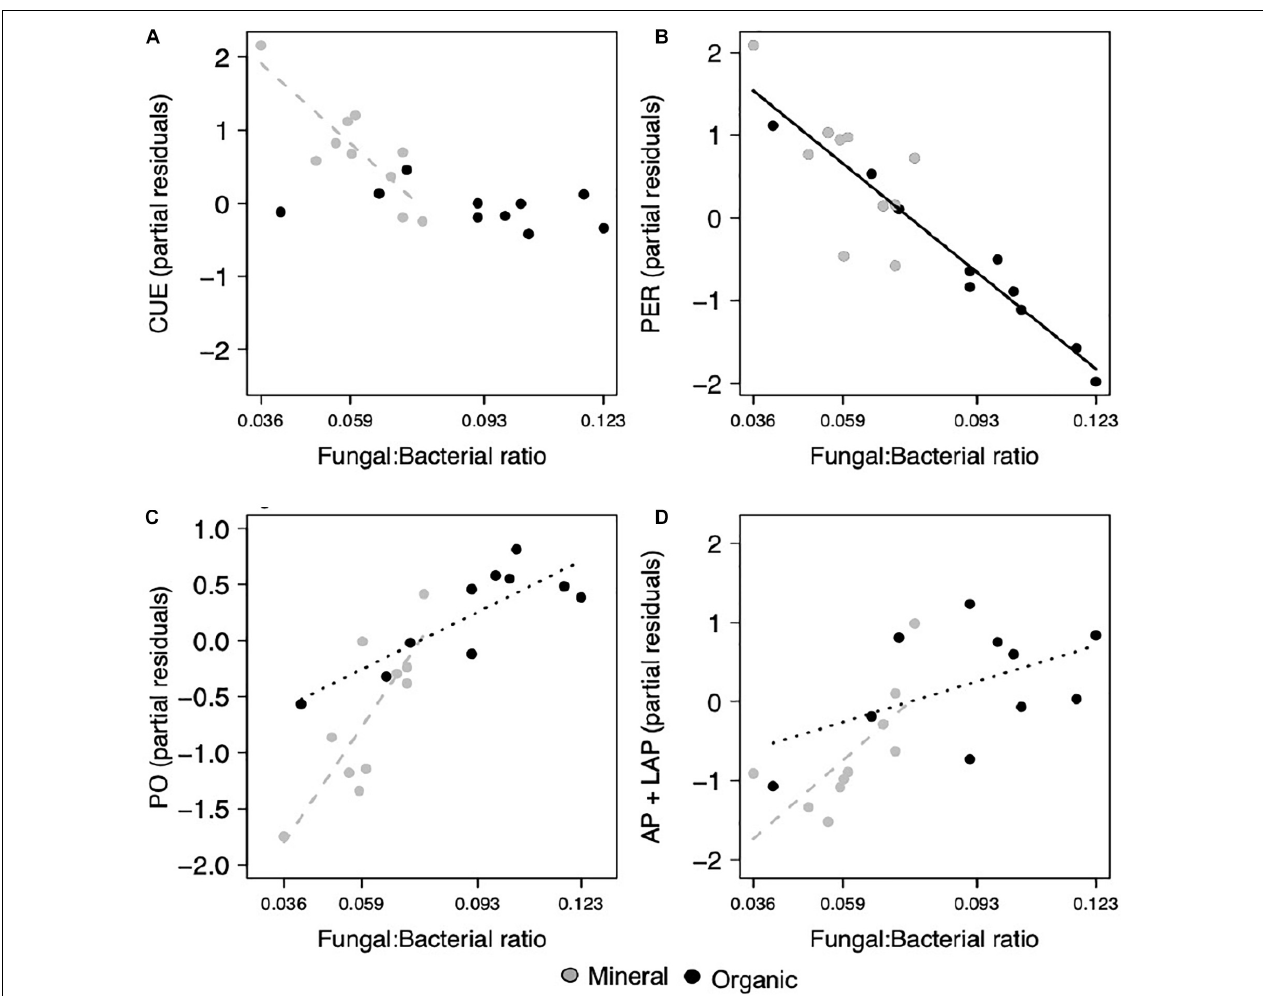
FIGURE 2 | Microbial functions responded to the fungal to bacterial ratio (F:B), where (A) CUE decreased in the mineral horizon, (B) PER activity decreased across both horizons, (C) PO activity and the combined activities of (D) AP and LAP increased in the mineral horizon and with marginal significance, increased in the organic horizon. Points represent the partial residuals of each response variable plotted against F:B ratio. Black solid lines represent linear relationships with no horizon interaction, while dashed lines represent individual horizon responses where the mineral horizon is represented by gray and the organic horizon by black ( p < 0.05). Dotted lines represent marginally significant relationships within an individual horizon ( p <